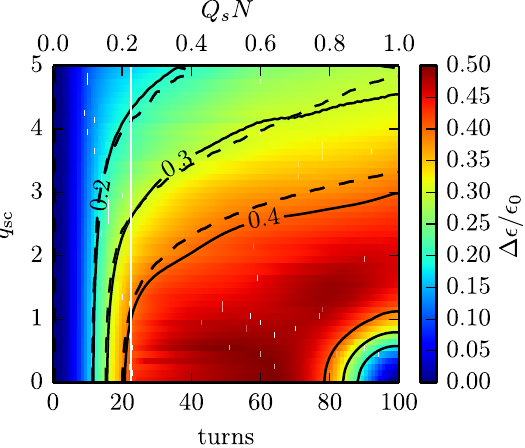
FIG. 11. Time evolution of the emittance growth for decoherence with space charge shown in Fig. 9. Colors and solid lines are from simulations of bunches. Dashed lines are 1 , calculated using Eq. (3) from the oscillation amplitude given by eff ¼ Eq. (17). The vertical white line is N